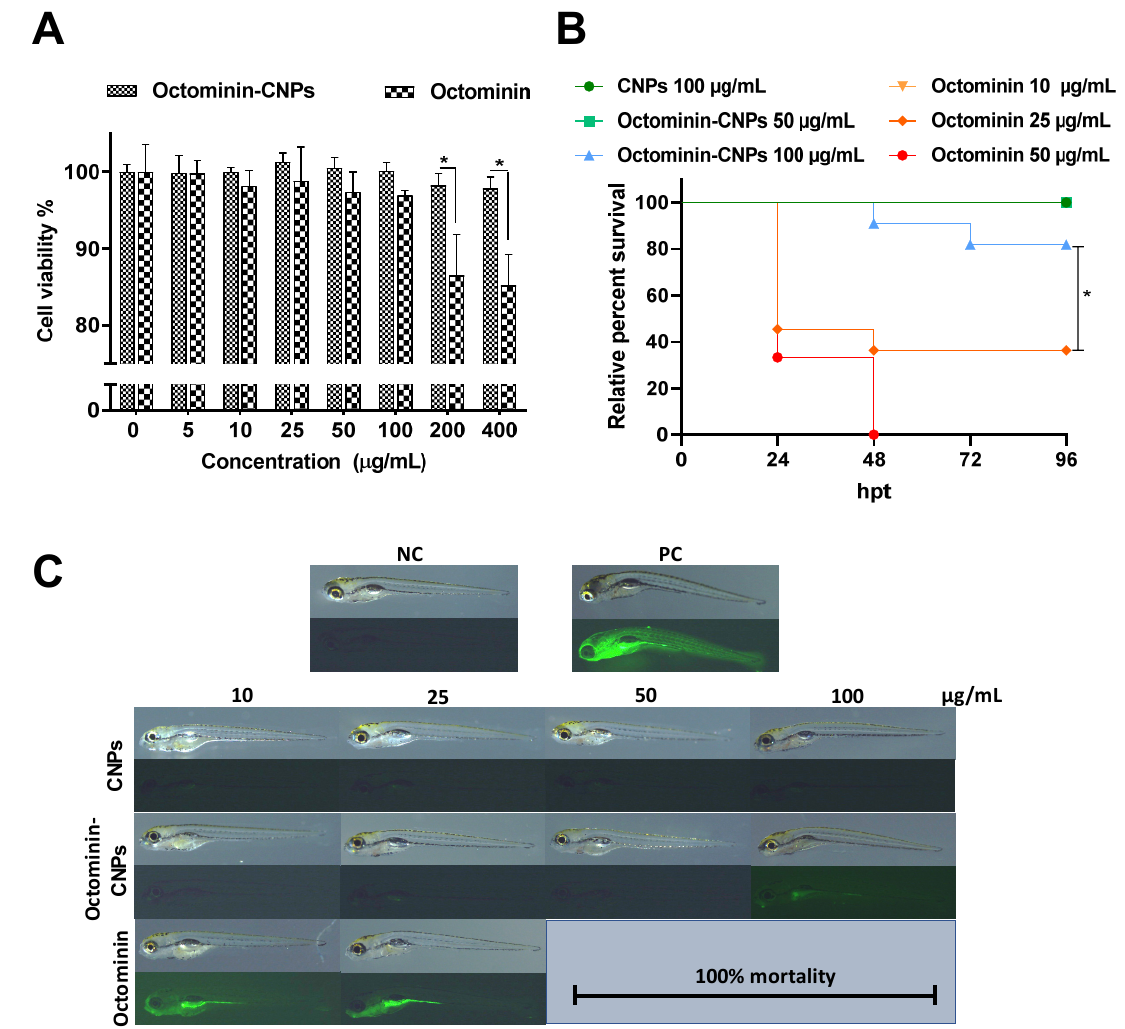
Figure 2. In vitro and in vivo toxicity determination of the Octominin-CNPs vs. Octominin. ( A ) 3-(4,5- dimethylthiazol-2-yl)-2,5-diphenyltetrazolium bromide (MTT) assay was conducted to determine Octominin-CNPs/Octominin cytotoxicity using human embryonic kidney 293 (HEK 293) cells. Cells (2.0 × 10 5 cells/mL) were treated with different concentrations of Octominin-CNPs and Octominin (0–400 µ g/mL) and incubated at 37 ◦ C for 24 h in a 5% CO 2 incubator. The supernatant was then replaced with MTT to determine the viability of the cells. * p < 0.05. The error bars indicate the mean ± SD (n = 3). ( B ) Relative present survival (RPS) of zebrafish larvae with Octominin-CNPs, Octominin, CNPs treatments. Zebrafish larvae at 60 h post-fertilization (hpf) were treated with different concentrations of Octominin-CNPs and Octominin (0–100 µ g/mL). RPS was determined at 12 h intervals. * p < 0.05, The error bars indicate the mean ± SD (n = 10). ( C ) Octominin-CNPs, Octominin induced reactive oxygen species (ROS) generation determination in zebrafish larvae. At 96 h post-treatment (hpt), larvae were stained with 2 (cid:48) 7 (cid:48) dichlorodihydro-fluorescein diacetate (H 2 DCFDA) and observed for green